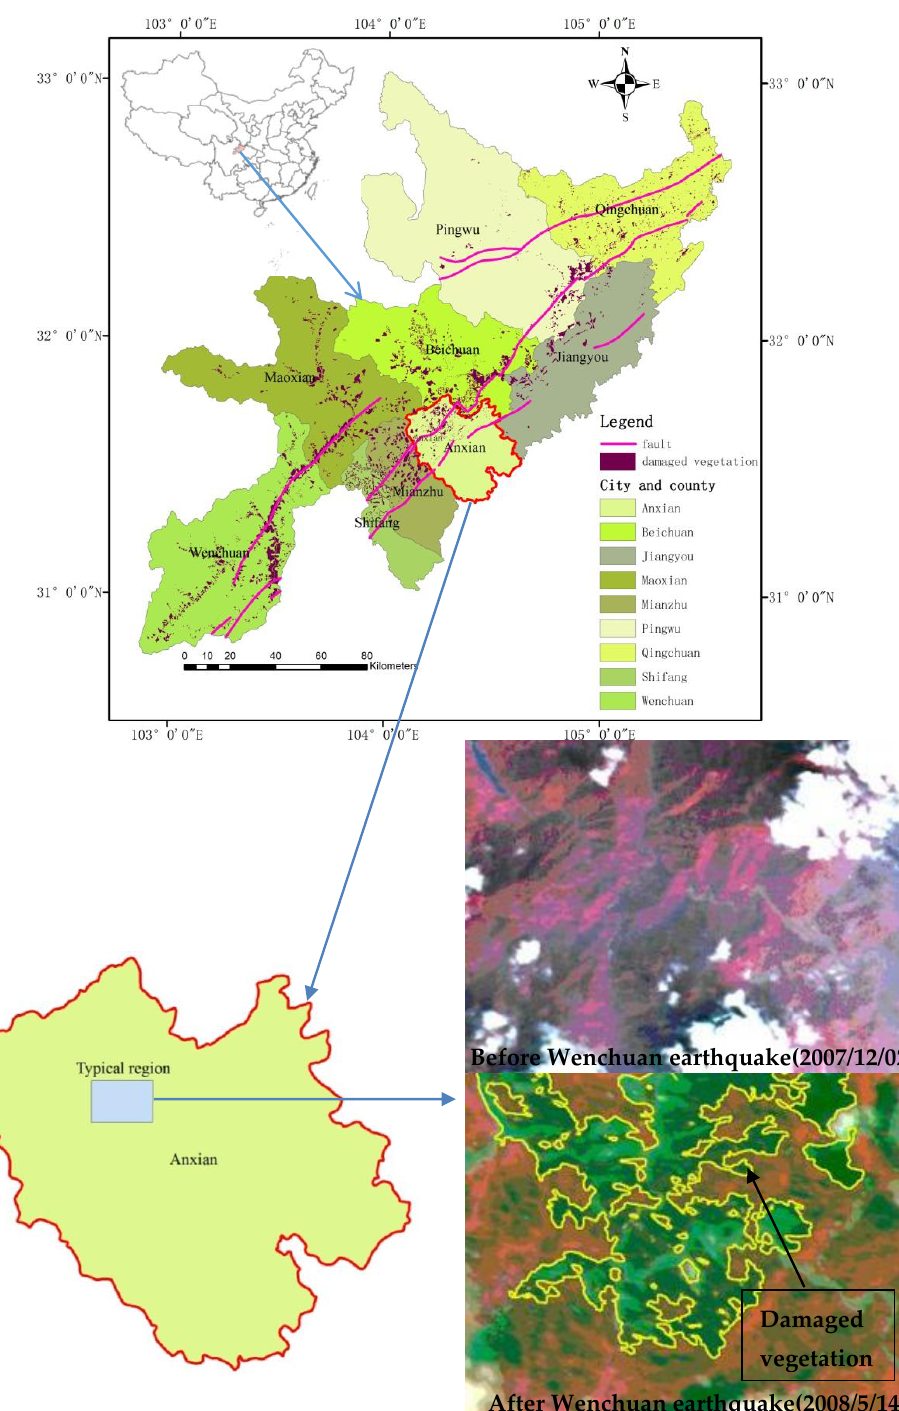
Figure 1. The distribution of damaged vegetation in nine worst-hit cities and counties and the typical CEBRS-02B image screenshots of damaged vegetation in the Wenchuan earthquake affected area.